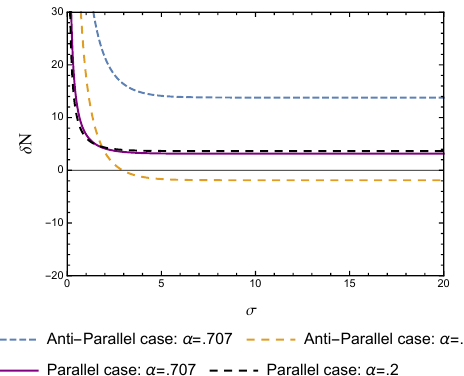
Figure 22 . Parallel and Anti-parallel motions in (1 + 1) dimensions with thermal background: δ N Vs σ plot with ∆ E = 1 , A = 3 . a B